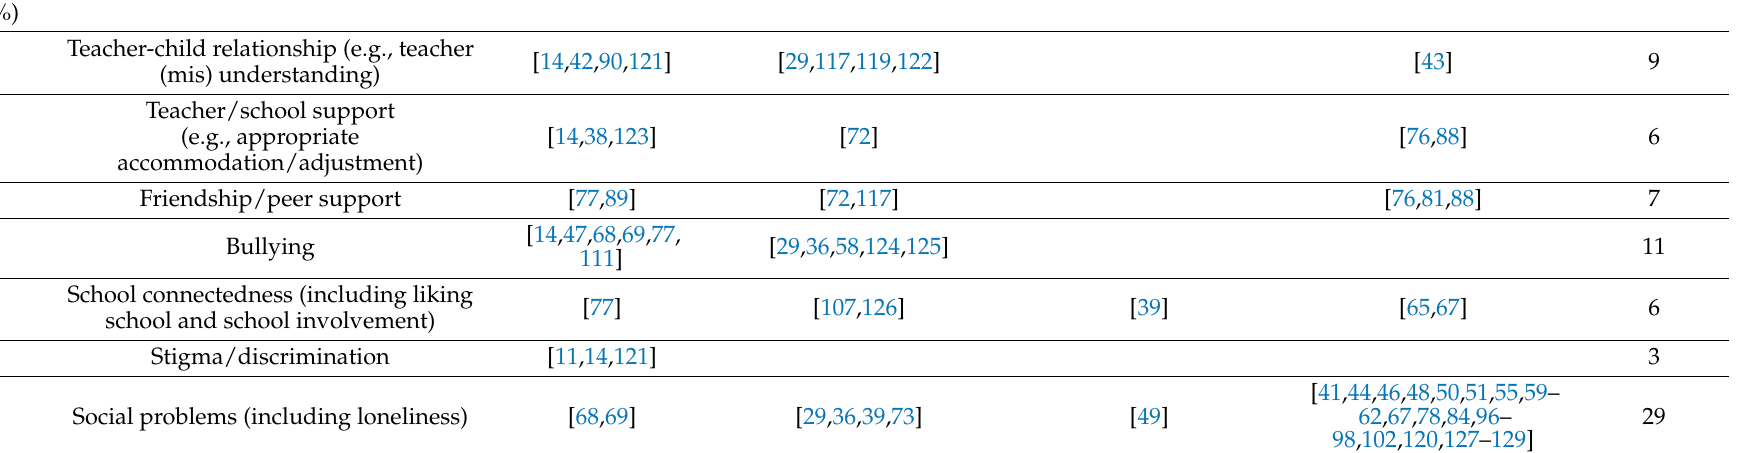
Third Factor and MH Measured. Association Not